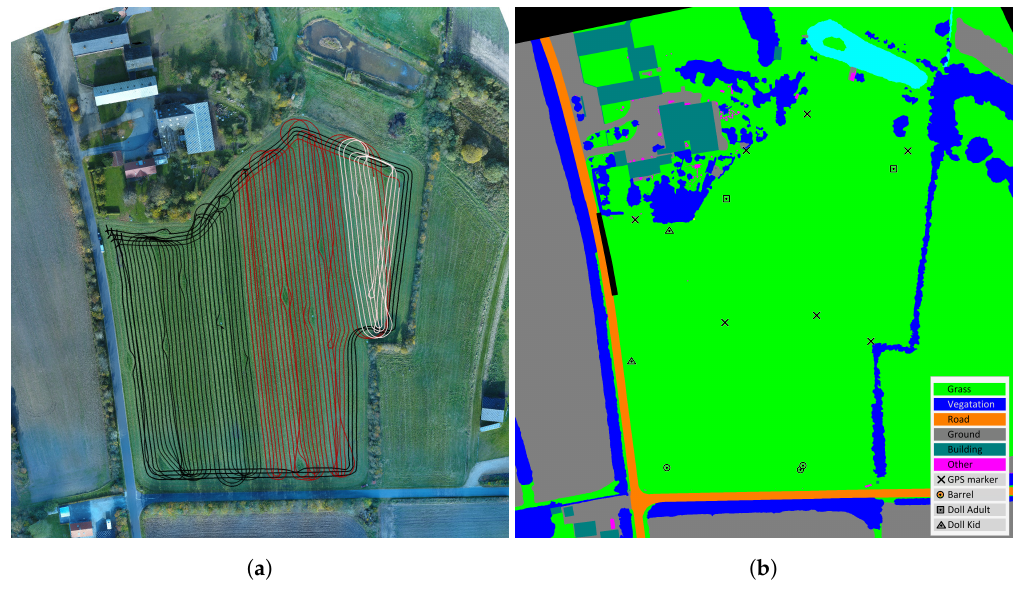
Figure 5. Colored and labeled orthophotos. ( a ) Orthophoto with tractor tracks overlaid. Black tracks include only static obstacles, whereas red and white tracks also have moving obstacles. Currently, red tracks have no ground truth for moving obstacles annotated. ( b ) Labeled orthophoto.